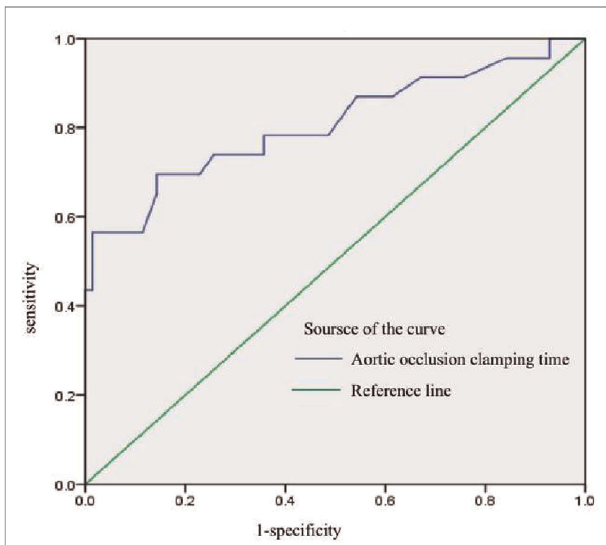
FIGURE 1 | Receiver operating characteristic curve for aortic occlusion clamping time.